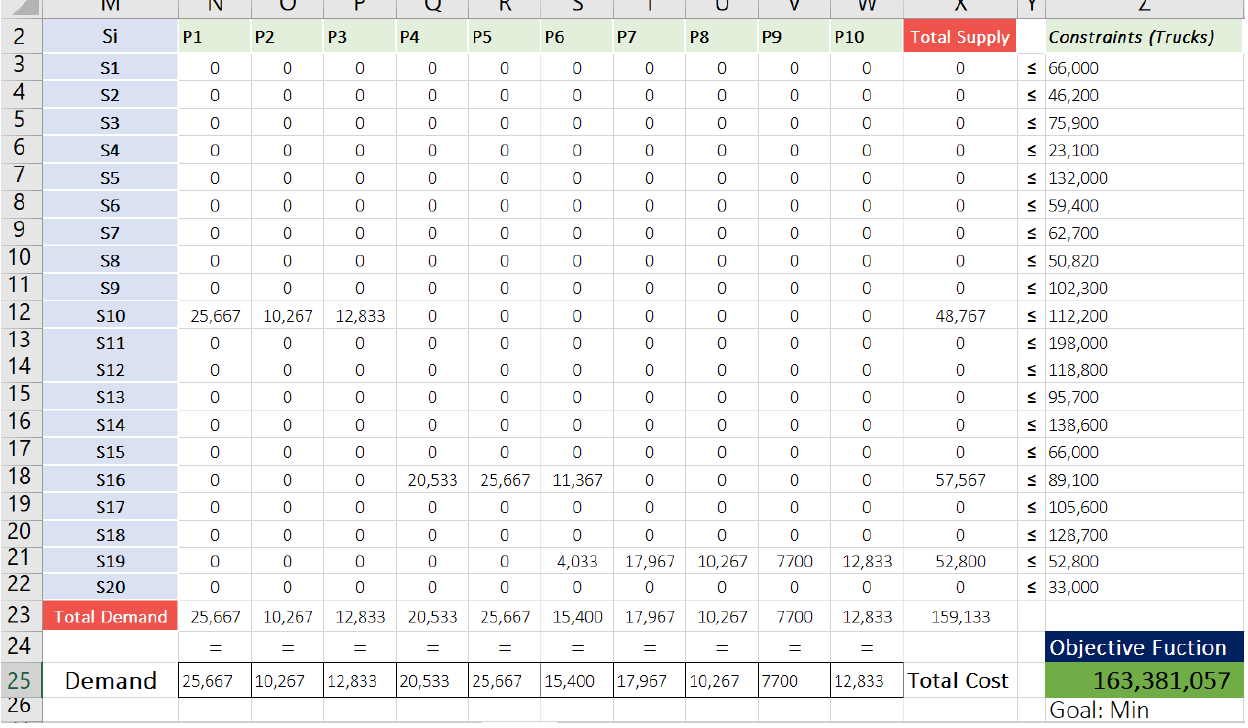
Figure 7. Optimal solutions calculated by MS Excel Solver .